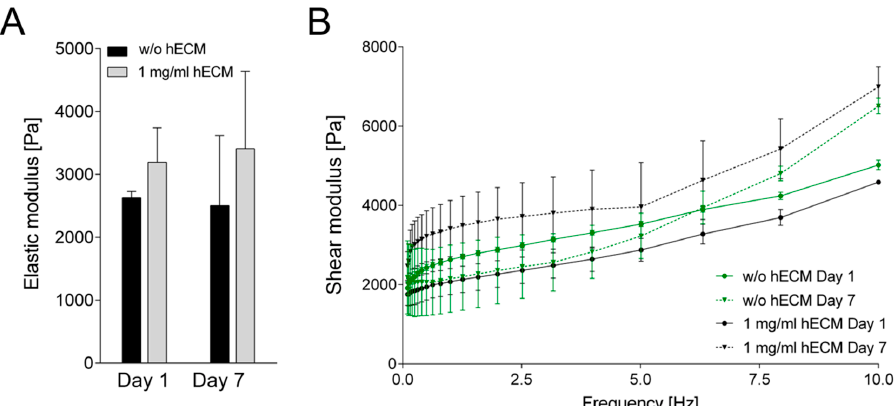
Figure 4. Rheological properties of 3D printed alginate/gelatin constructs with varying hECM concentration. ( A ) Comparison between 0 and 1 mg/mL hECM, one and seven days after printing. Elastic modulus of the wet bioink formulations were measured at a frequency of 1 Hz and 0.1% shear strain at 37 °C; ( B ) Shear modulus of 3D printed constructs at increasing frequencies (0.1–10 Hz). Results are shown as mean ± SEM of a triplicate experiment.